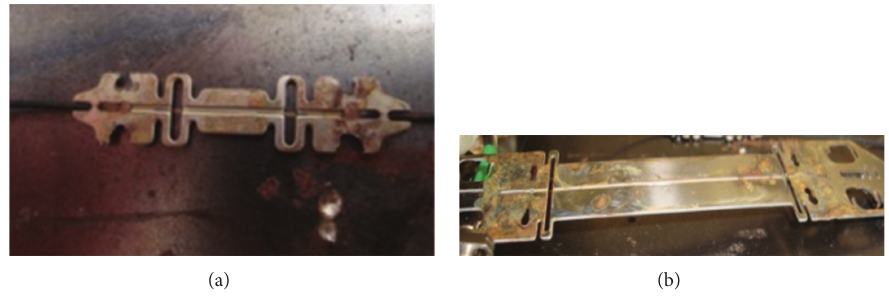
Figure 9: FBG 1 and FBG 2 without instrumentation to steel